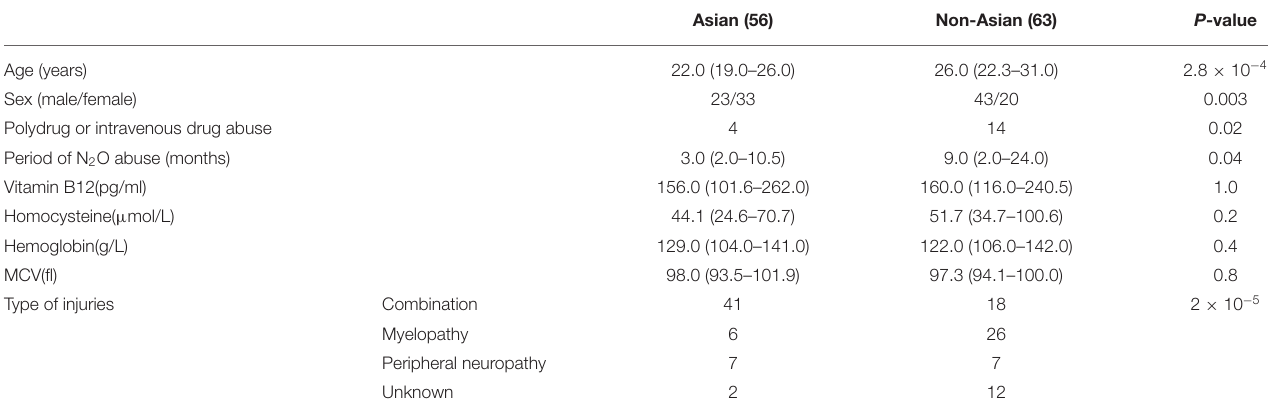
TABLE 2 | Comparison of demographic and clinical features of Asian and non-Asian